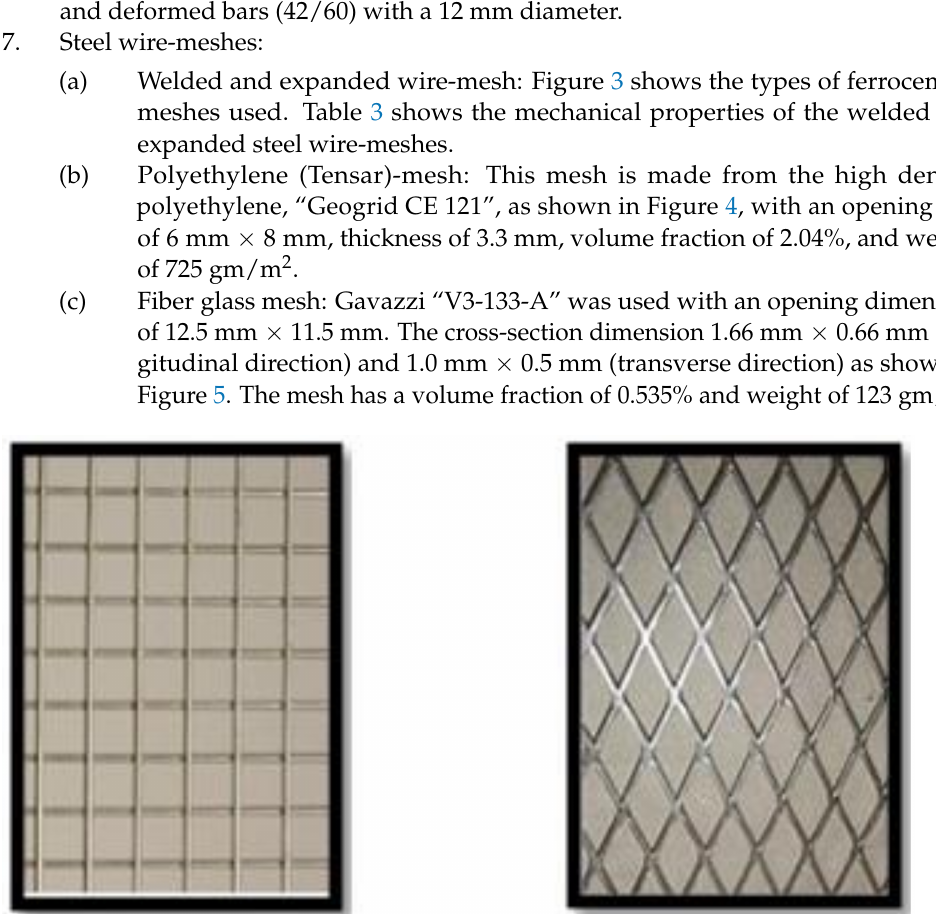
Figure 3. Types of meshes. ( a ) Welded wire-mesh, ( b ) Expanded wire-mesh [29].